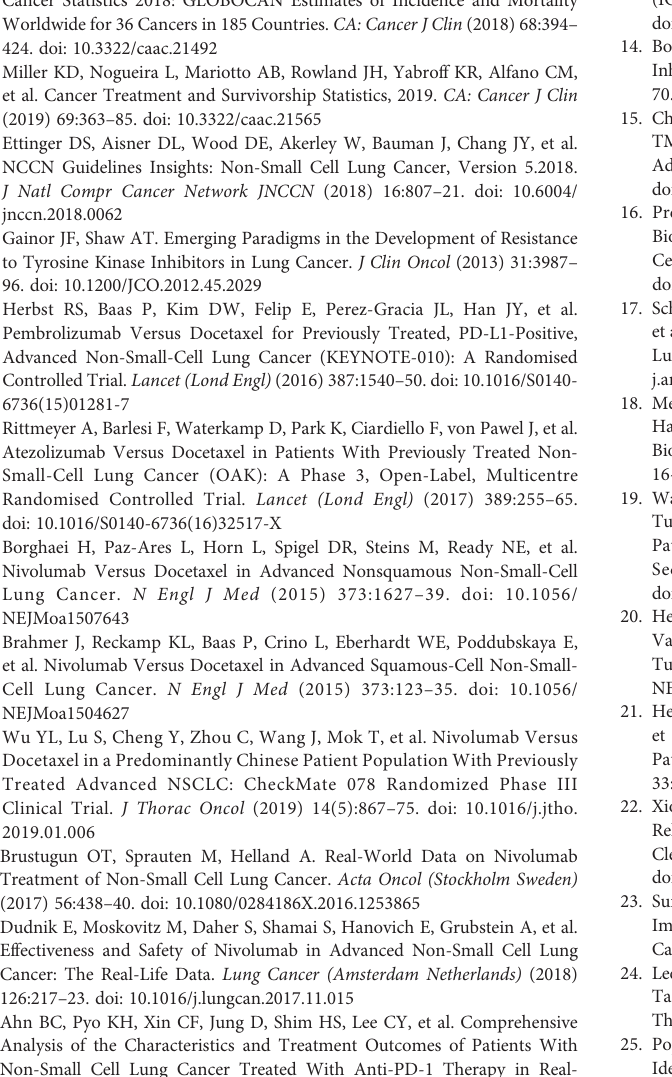
Supplementary Table 1 | Demographic characteristics of NSCLC patients treated with anti-PD-1 immunotherapy in three cohorts. Supplementary Table 2 | Model information about BRGPI. Supplementary Figure 1 | The analysis pipeline of the construction and validation of BRGPI for NSCLC patients treated with anti-PD-1 immunotherapy. Supplementary Figure 2 | Representative staining images of eight genes from the BRGPI model and PD-L1 at different levels. Supplementary Figure 3 | Strati fi cationanalysisofBRGPIforitspredictivevalueof progression-freesurvivalinNSCLCpatientstreatedwithanti-PD-1immunotherapy. (A, B) Kaplan-Meier survival curve ofprogression-freesurvivalfor non-squamous (A) and squamous-cell (B) NSCLCpatients treated with anti-PD-1 immunotherapybased on theBRGPIintheGSE93157cohort. (C,D) Kaplan-Meiersurvivalcurveofprogression-